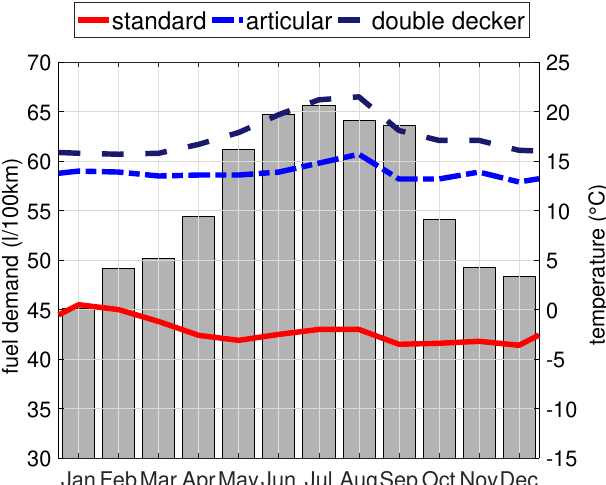
Figure 2. Fuel demand of diesel buses (dBus) in accordance with the ambient